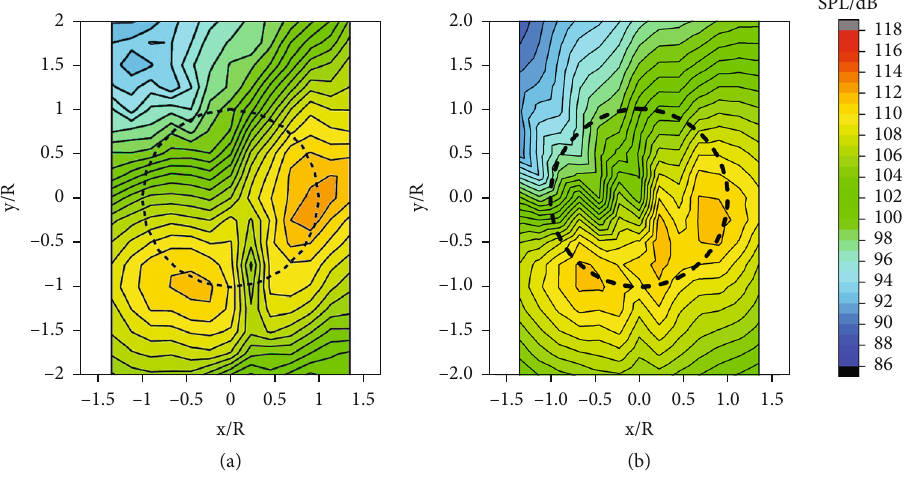
Figure 7: Predicted and measured SPL noise contours.